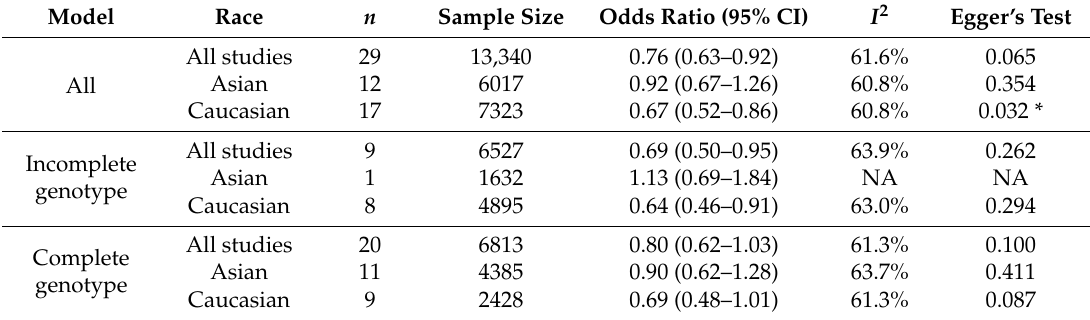
Figure 1. Flow diagram for the identification process of eligible studies. Table 1. Combined results of the dominant model (GG + GC vs. CC) for examining the correlation between PPARG Pro12Ala and CKD.